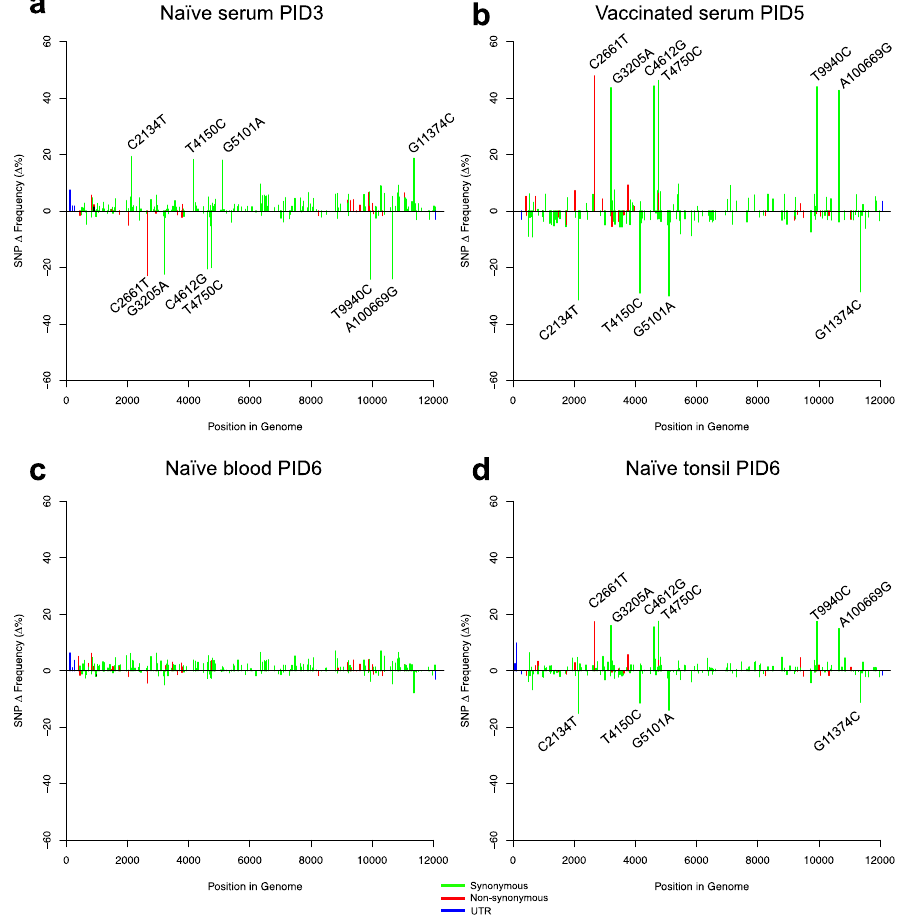
Figure 5. Relative SNP frequency distributions in the challenge virus depicted as the mean frequency change of SNPs for the vaccinated and naïve groups compared to the inoculum as Δ %. SNPs with large changes in frequency are labelled on the plots. Samples were: ( a ) Serum (PID3) from naïve pigs. ( b ) Serum (PID5) from vaccinated pigs. ( c ) Blood (PID6) from naïve pigs. ( d ) Tonsils (PID6) from naïve pigs. The red, green, and blue colours of the bars represent non-synonymous, synonymous, and untranslated region (UTR) mutations, respectively.